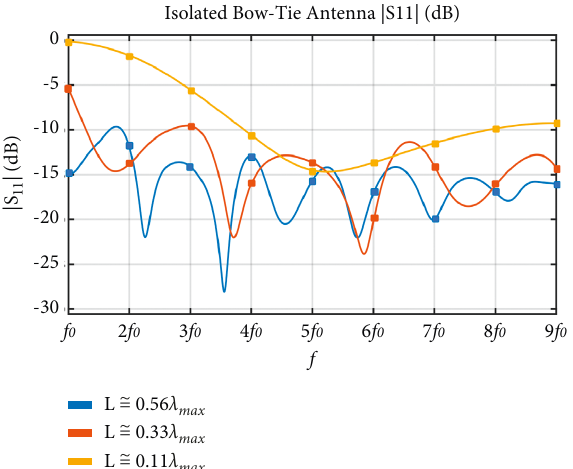
Figure 3: Input reflection coefficient magnitude | S ° flare angle supplied with a 200 Ω 11 | (dB) for an isolated bow-tie antenna with 77.3 discrete source. Three different antenna lengths have been considered.